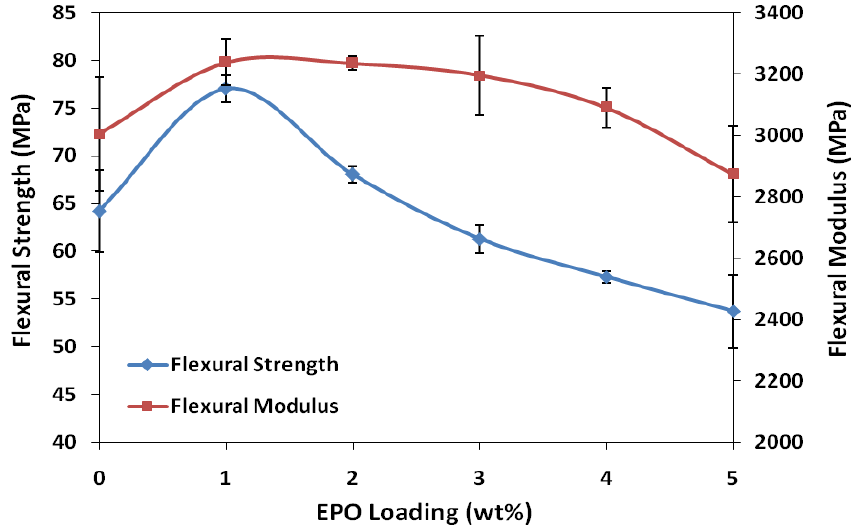
Figure 3. Flexural strength and modulus of neat PLA and PLA/EPO